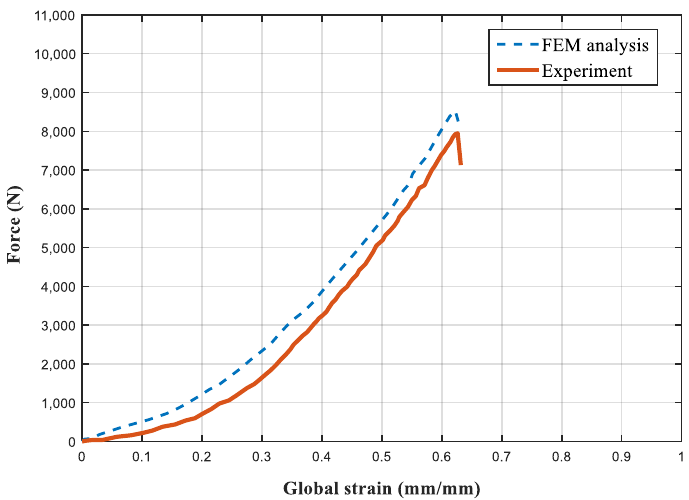
Figure 5. Comparison of numerically predicted force-strain curves with experimental results.